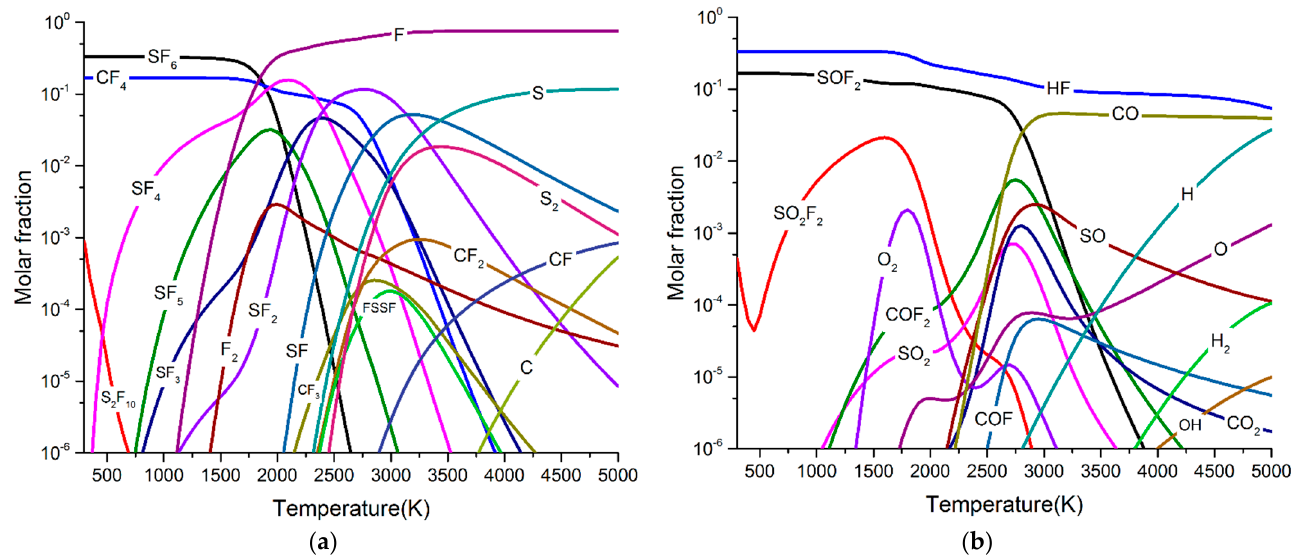
Figure 10. Particle composition of 60% SF 6 + 20% CF 2 + 20% H 2 O arc plasma at 0.6MPa. ( a ) SF 6 , SF 5 , SF 4 , SF 3 , SF 2 , SF, S, S 2 , F, F 2 , FSSF, S 2 F 10 , CF 4 , CF 3 , CF 2 , CF, and C particles. ( b ) SOF 2 , SO 2 F 2 , COF 2 , COF, O 2 , O, SO 2 , SO, CO 2 , CO, HF, H, H 2 , and OH